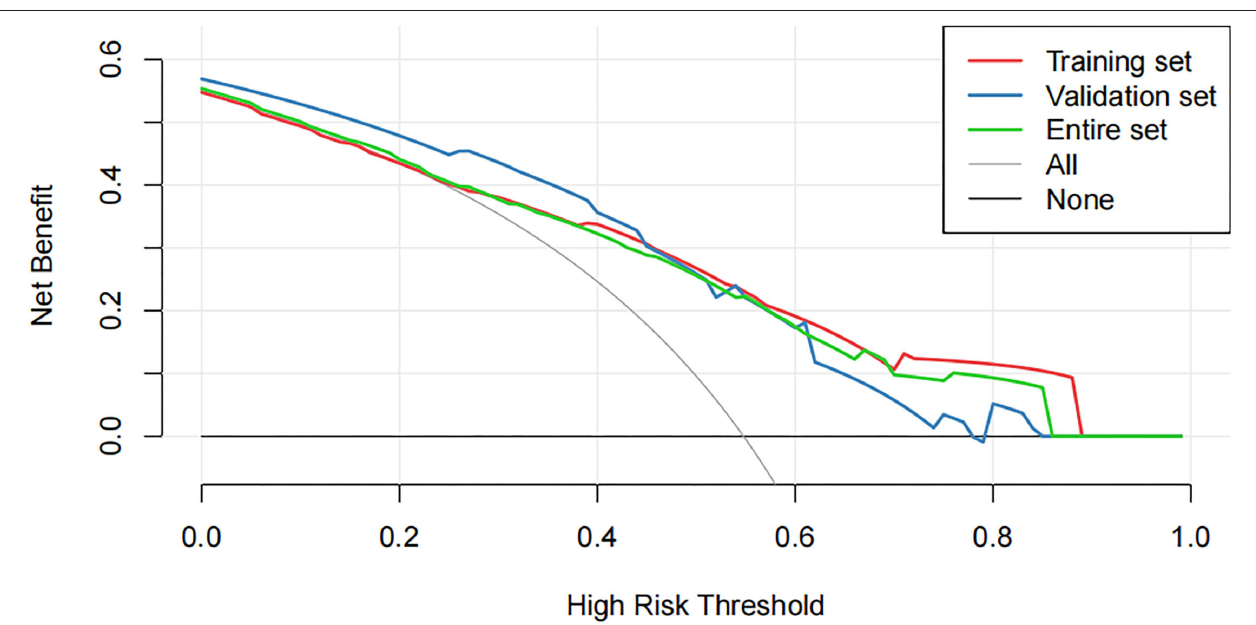
FIGURE 5 | The decision curve analysis (DCA) curve shows the decision analysis for the entire set, the training set, and the validation set.